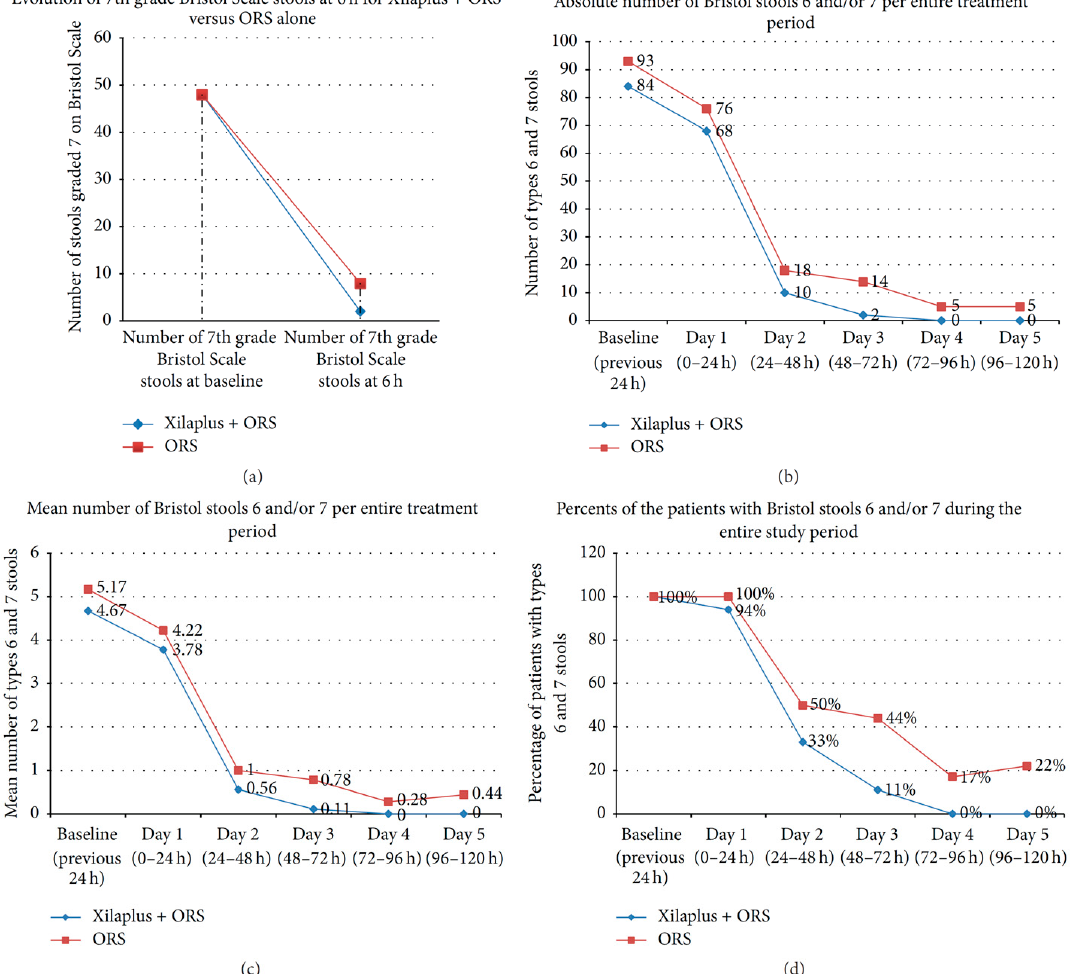
Figure 4. Evolution of type 6 and 7 Bristol Scale stools (the most dehydrating types of stools) in both groups of children (3 months–12 years) (Xyloglucan − Xilaplus- + ORS and ORS) over five days. ( a ) Evolution of the absolute number of type 7 stools during the first 6 h. ( b ) Evolution of absolute number of type 6 and 7 stools during the study period. ( c ) Evolution of mean number of type 6 and 7 stools during the study period. ( d ) Evolution of the percentage of patients with type 6 and 7 stools during the study period [24].